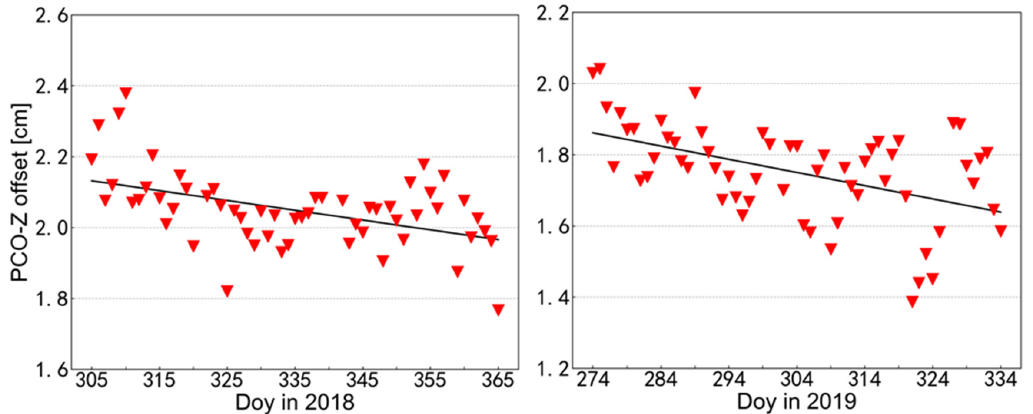
Figure 8. Estimation of the PCO z-component (red triangle) for HY-2B at the beginning of the satellite’s mission ( left ) and one year later ( right ). The black line is the trend line fitted by least squares.